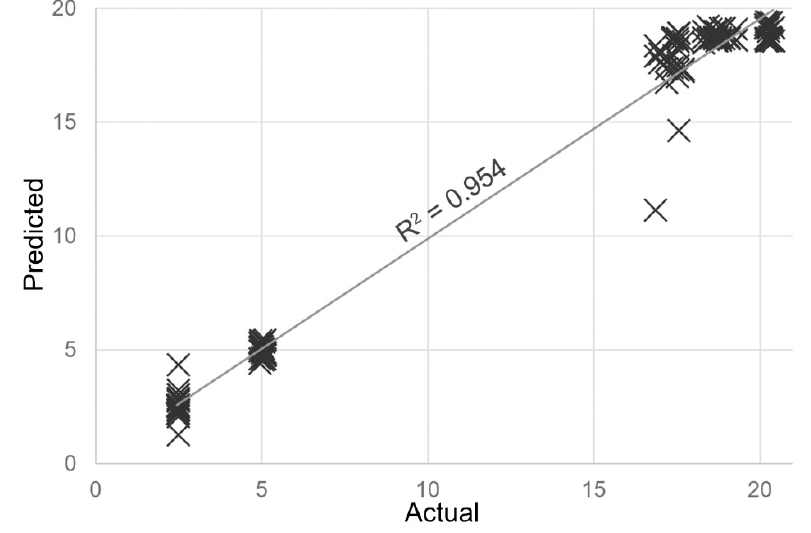
Figure 4. A plot of the BAI values determined in poultry meat samples stored over a period of 5 days using DLLME-GC-MS and the corresponding BAI values estimated with a trained artificial neural networks (ANN) model based on the results of headspace analysis using an electronic nose device.